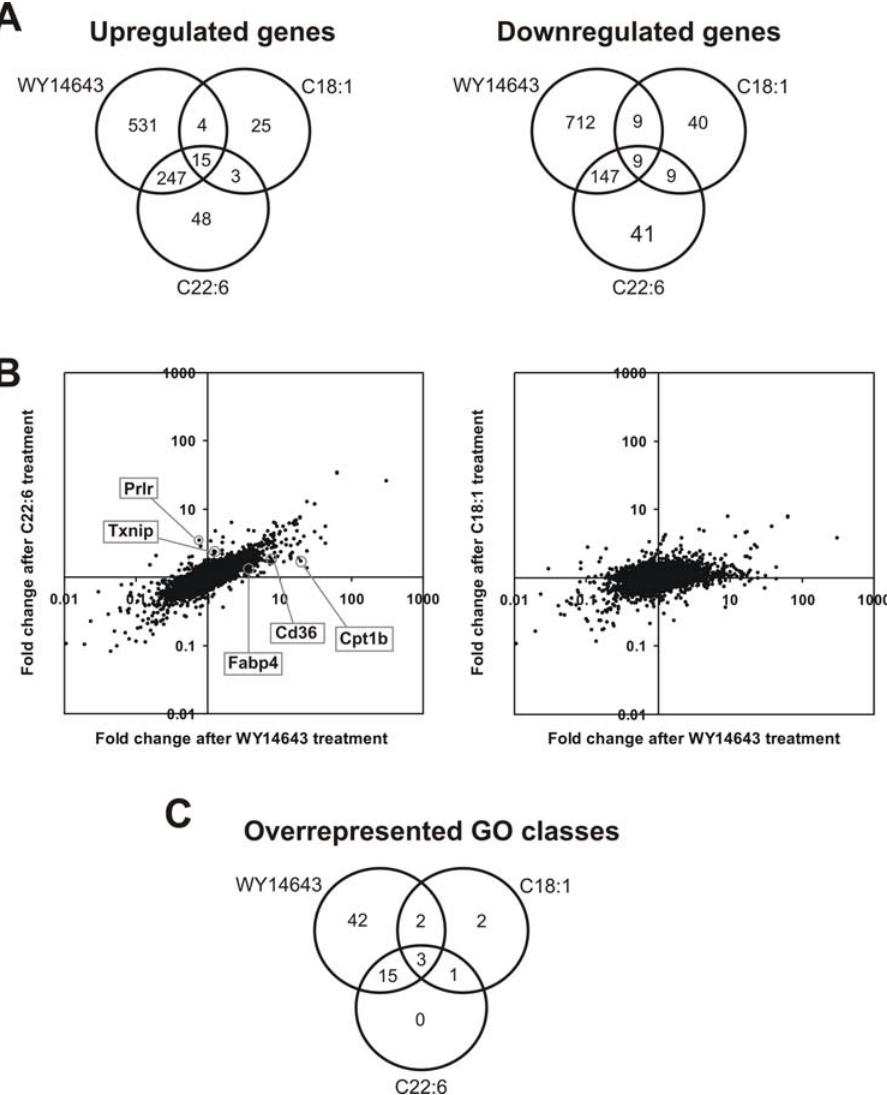
Figure 3. Similarities between two dietary unsaturated fatty acids and the synthetic PPAR a agonist WY14643. (A) Venn diagrams showing the overlap in up- (left panel) and downregulated (right panel) genes after treatment with WY14643, C22:6 and C18:1. Genes were considered statistically significantly regulated if P , 0.01. (B) Scatter plots demonstrating similarities in gene regulation between C22:6 and WY14643. Graphs show fold change in gene expression after treatment with WY14643 compared to C22:6 and C18:1. Genes that are upregulated disproportionally strongly by WY14643 ( Cd36 , Fabp4 ( aP2 ), and Cpt1b ), or by C22:6 ( Prlr and Txnip ) are marked. In constructing the scatter plots, all probesets left after IQR-filtering were used. (C) Overlap in overrepresented Gene Ontology classes between C22:6, C18:1, and WY14643, based on a functional class score (FCS) method. The GO class unique to C22:6 and C18:1 is GO:0016070 (RNA metabolism), whereas the GO classes unique to C18:1 are GO:0007409 (axonogenesis) and GO:0016072 (rRNA metabolism). Hierarchy between dietary unsaturated fatty acids Of all fatty acids studied, the number of significantly changed genes was highest for C22:6, followed by C18:3. The number was about equal for C20:5 and C18:2, while much fewer genes were changed after C18:1 treatment. Since the dietary fatty acids regulated gene expression principally via PPAR a , the data are indicative of a hierarchy in in vivo PPAR a -activating potency between dietary unsaturated fatty acids. Direct evidence for this notion came from comparison of fold-changes in expression of PPAR a target genes between the various fatty acid treatments. Genes involved in two major PPAR a -regulated pathways were examined: mitochondrial fatty acid oxidation and peroxisomal